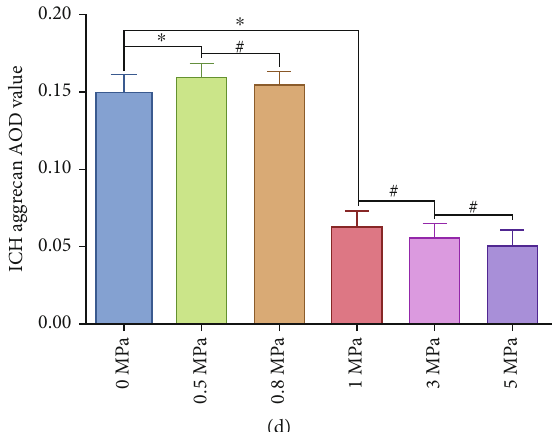
Figure 3: E ff ect of hydrostatic pressure on synthesis of aggrecan of the rabbit notochordal NP and fi brocartilaginous inner AF: (a) aggrecan IHC staining of the notochordal NP under graded hydrostatic pressure (200x); (b) statistic analysis of IHC aggrecan AOD value of the notochordal NP under graded hydrostatic pressure; (c) aggrecan IHC staining of the fi brocartilaginous inner AF under graded hydrostatic pressure (200x); (d) statistic analysis of IHC aggrecan AOD value of the fi brocartilaginous inner AF under graded hydrostatic pressure. ∗ P < 0 : 05 . # P > 0 : 05 . Scale bar = 100 μ